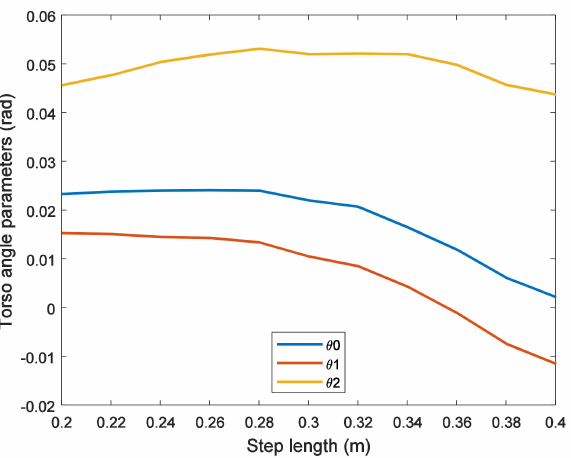
Figure 13. Torso angle parameters of TPM with different step lengths when T c = 1.0